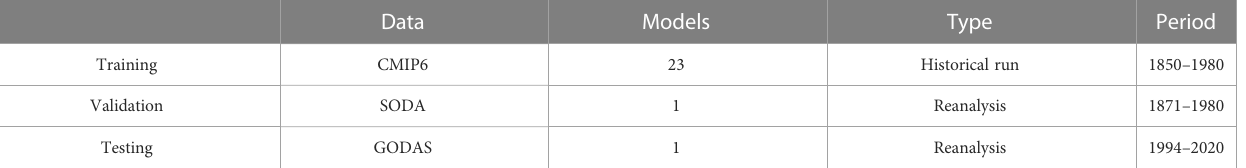
TABLE 3 The training, validation and testing subsets for Nino3.4 index prediction on CMIP6